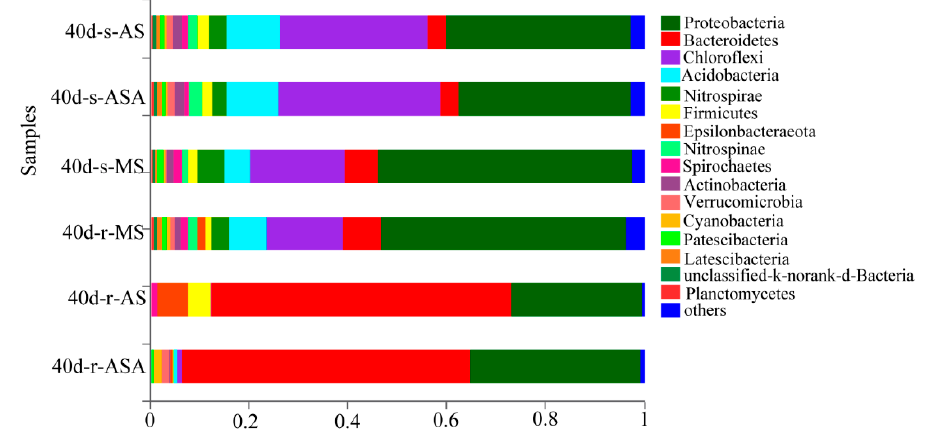
Figure 8. Bar plot of the bacterial community in the rhizosphere soil and root at the phylum level.